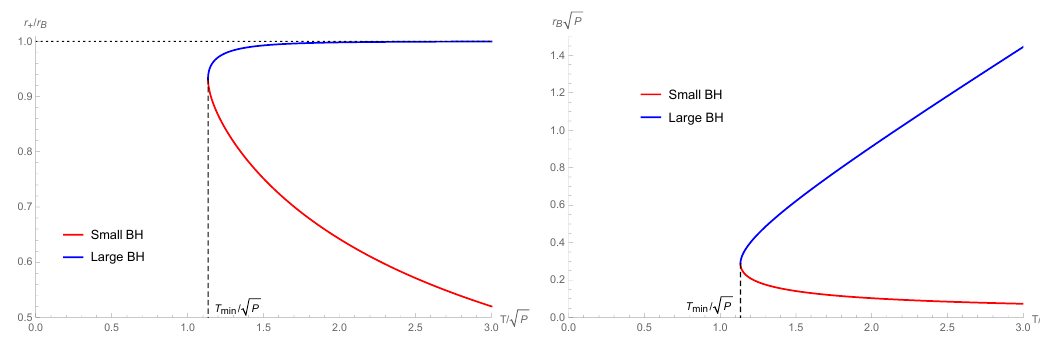
p p P against T= P for a Schwarzschild black hole in a cavity.